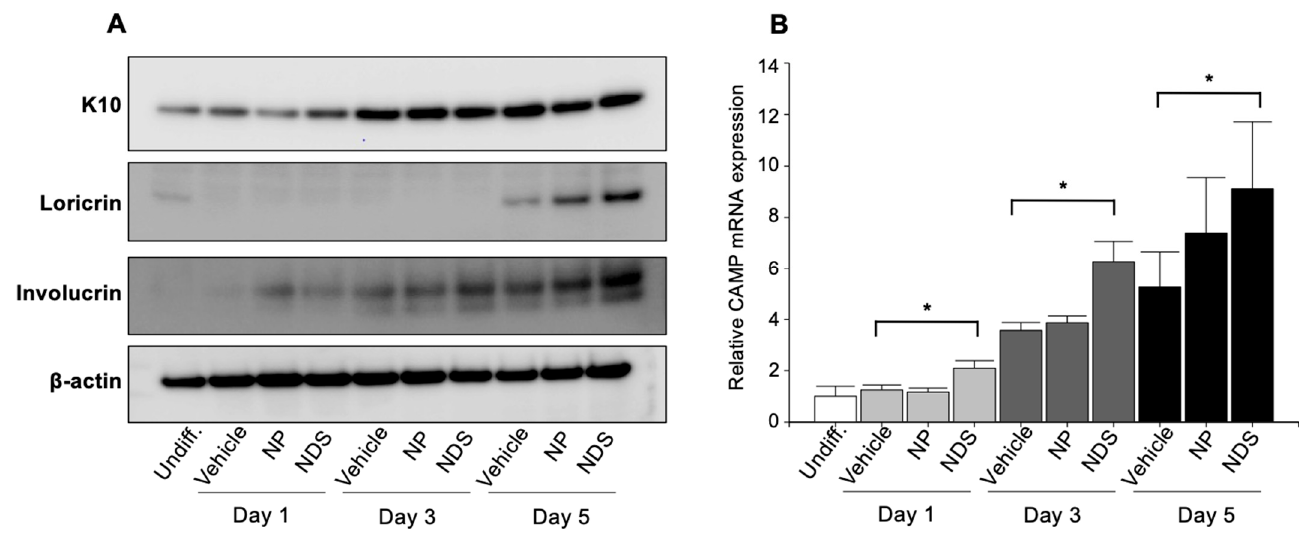
Figure 4. Exogenous ceramide stimulates KC differentiation and increases CAMP mRNA expression. ( A ) Western blot analysis (cultured in 0.07 mM Ca 2+ serum-free KC medium). ( B ) CAMP mRNA levels were assessed by q RT-PCR. Cells are incubated with 250 µM of NP or NDS. Undiff = undifferentiated KC. n = 3, Mean ± SD, * p < 0.01 vs. vehicle. Please see details in Material and Methods.